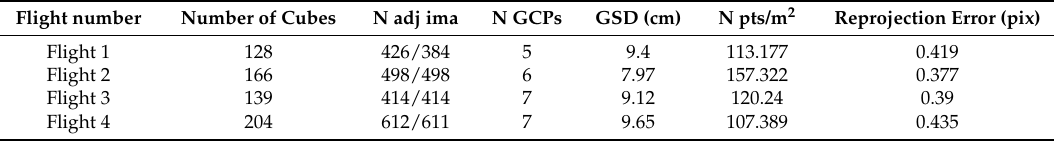
Table 3. Results of geometric processing by the PhotoScan. N adj ima: number of images used in the adjustment; N GCPs: number of GCPs; GSD: Ground Sample Distance; N pts/m 2 : number of points in m 2 in the dense digital surface